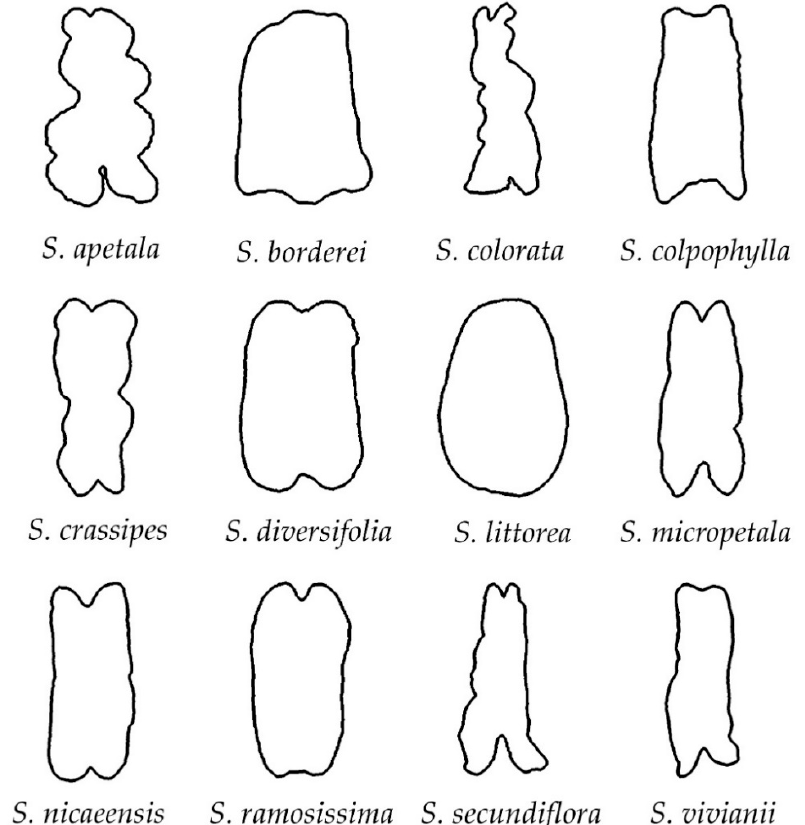
Figure 3. Silhouettes of the dorsal views of Silene seeds belonging to the group of smooth seeds.